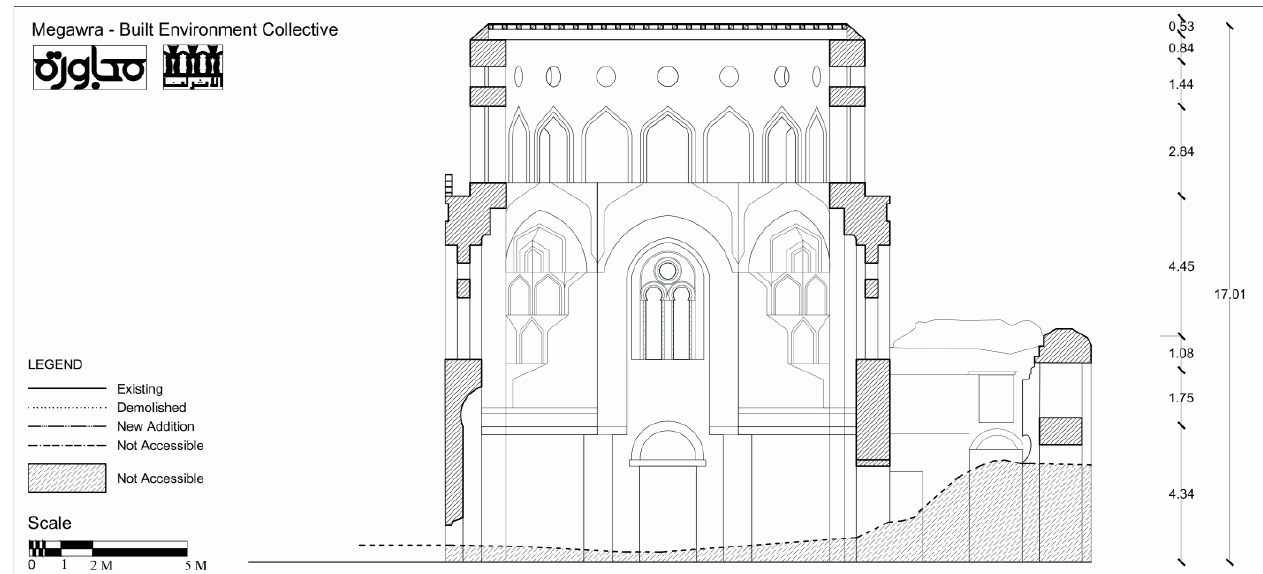
Figure 6. North-east Section of the dome of Fatima Khatun (Reproduced with permission from MEGAWRA-BEC, unpublished report, 2017 [38]).